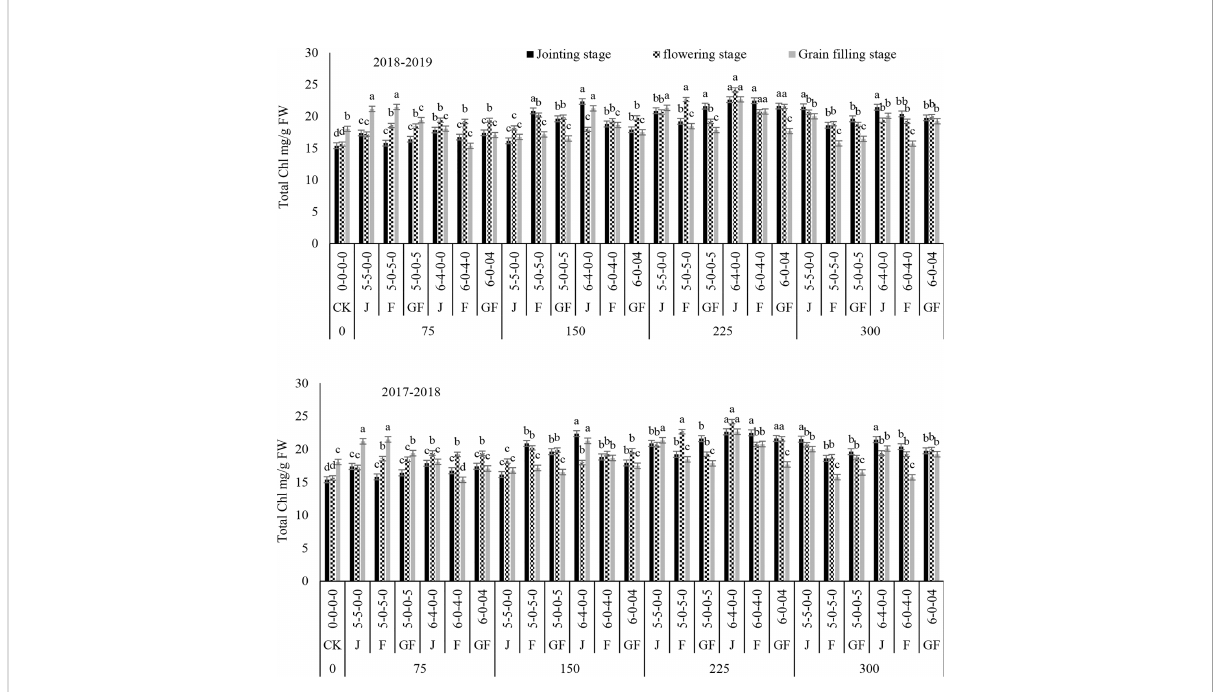
FIGURE 9 Effect of nitrogen fertilizer management on the total chlorophyll content of winter wheat. FW , fresh weight; JS , jointing stage; FS , fl owering stage; GF , grain fi lling stage. Different letters in above bars indicate a signi fi cant difference (p>0.05).